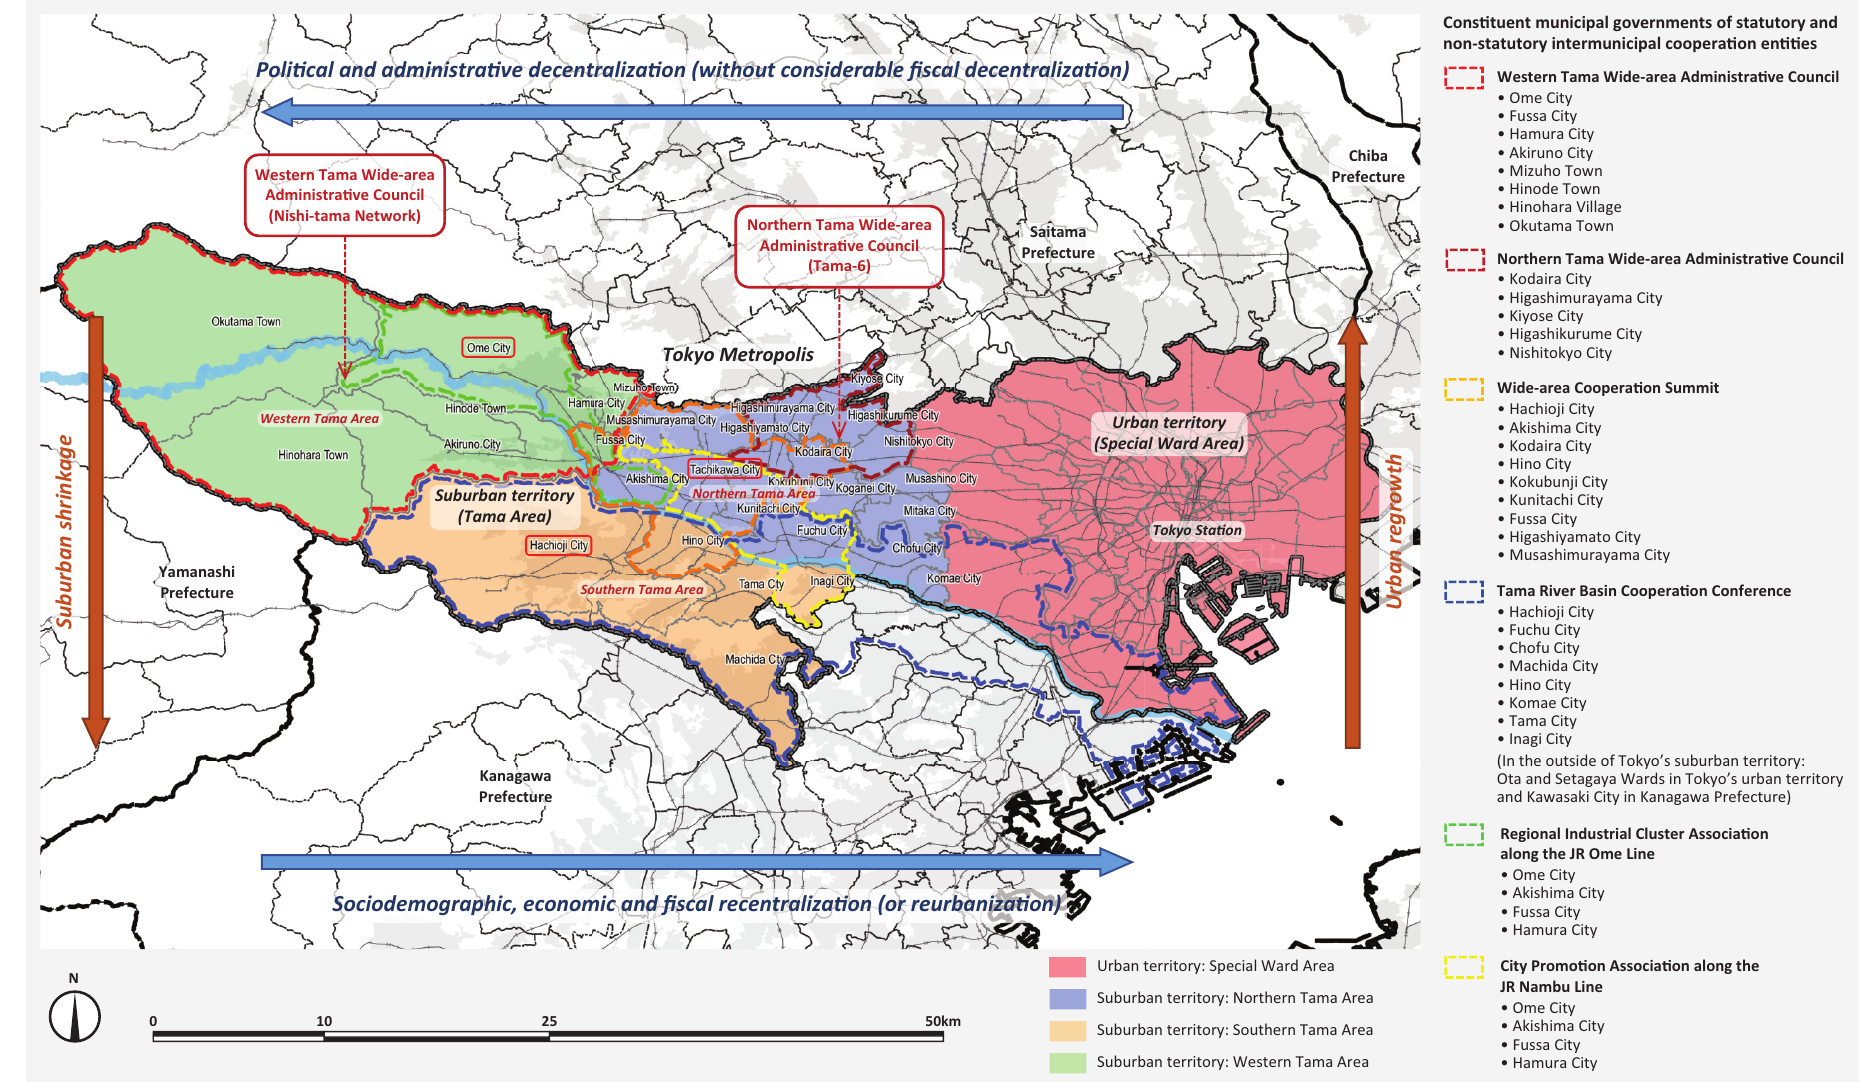
Figure 1. Tokyo’s suburban territory amid decentralization and recentralization and with statutory and non‐statutory IMC activities. Note: The Tama Council for the Promotion of Tourism comprises the chambers of commerce and industry of all municipalities, Tokyo Association of Mayors, Tokyo Town & Village Association, etc. Urban Planning, 2022, Volume 7, Issue 3, Pages